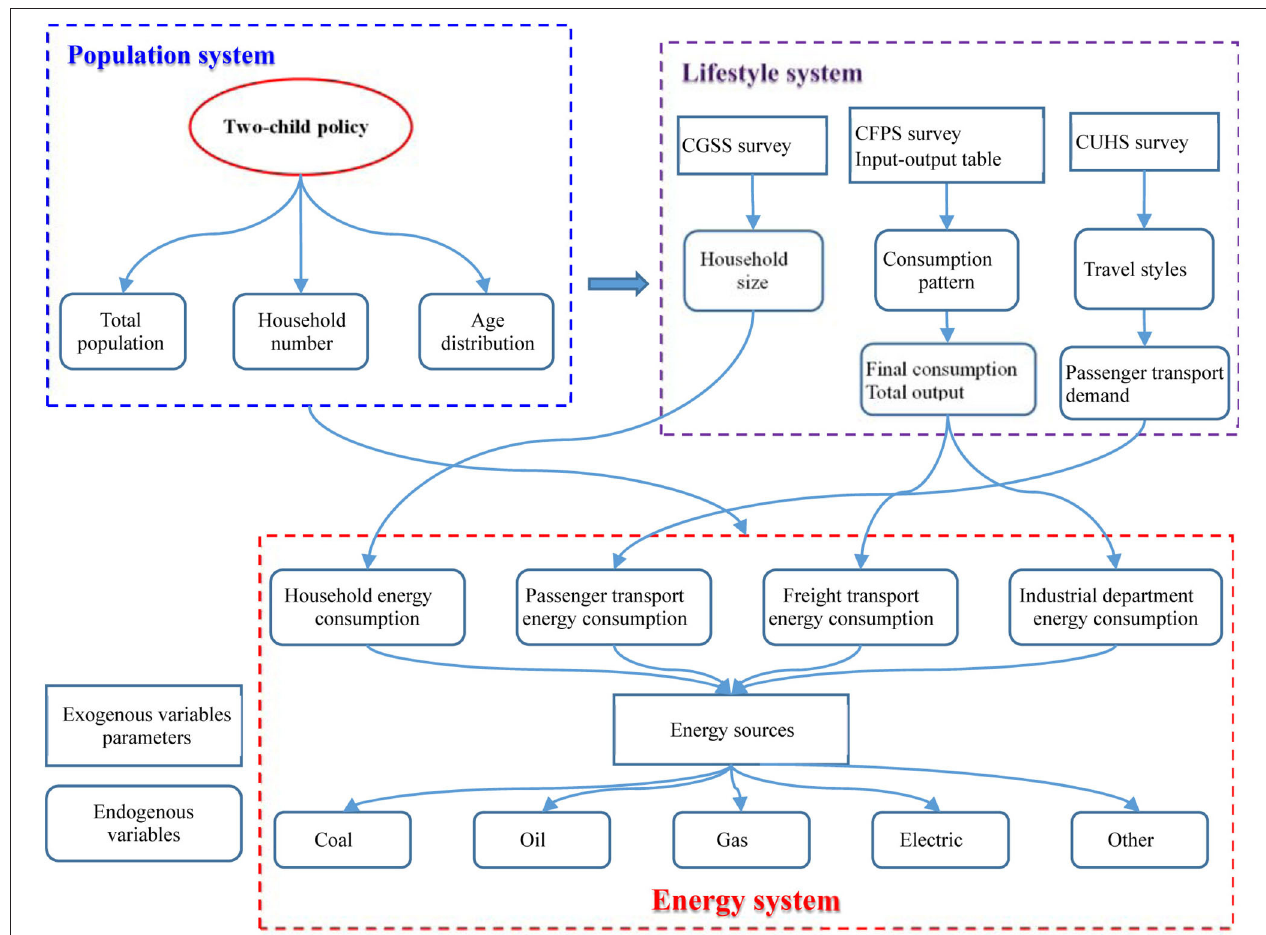
FIGURE 1 | Population-Lifestyle-Energy (PLE) model: the impact of the two-child policy on energy consumption.